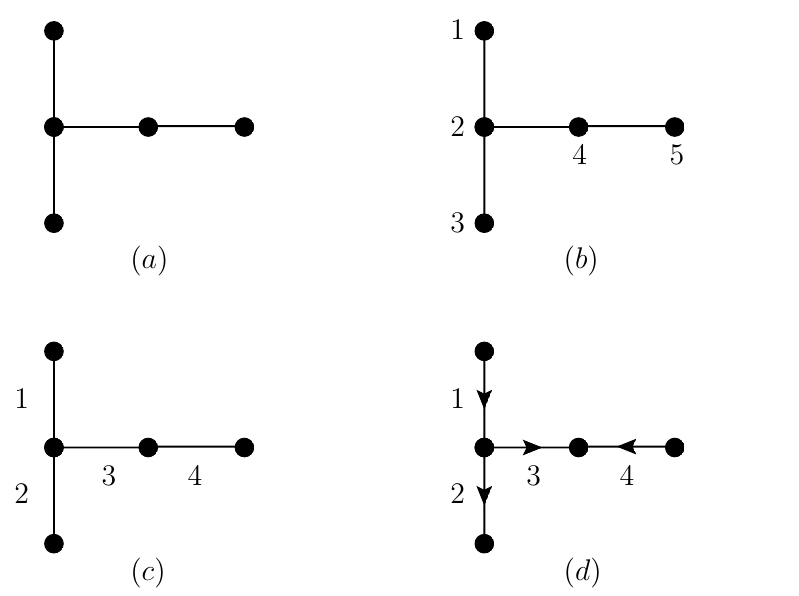
Figure 3 . a) An unlabeled tree. b) A tree with labeled vertices. c) A tree with labeled edges. d) A directed tree with labeled